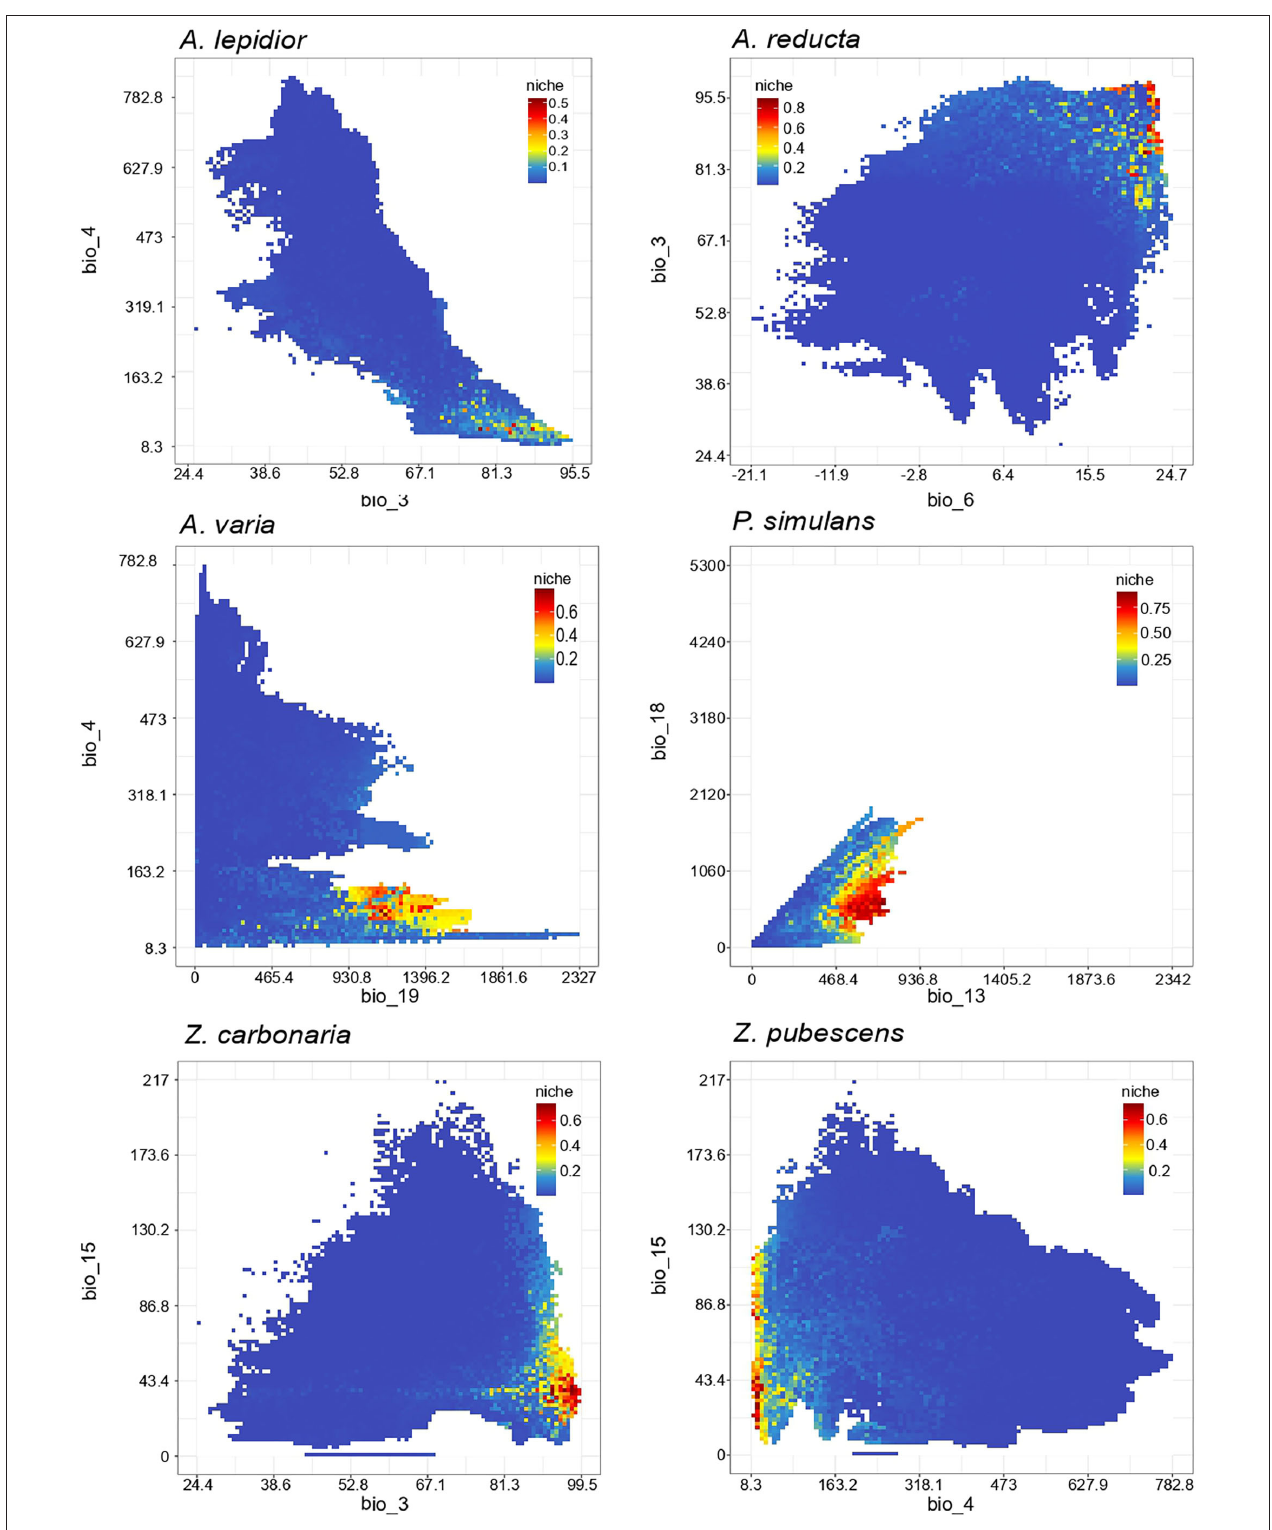
FIGURE 8 | Observed niche of Colombian spittlebugs as a function of two most representative biovariables. The scale shows occurrence probabilities.